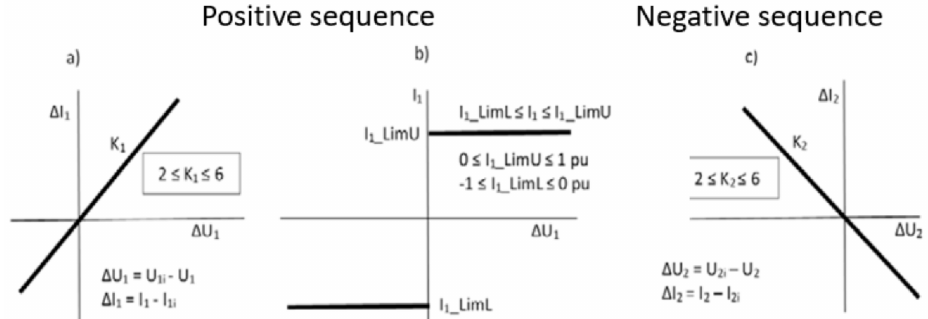
Figure 3. ( a ) Injection/consumption of additional positive reactive current ( ∆ I 1 ,r ) depending on positive voltage drop; ( b ) total reactive current Injection/Consumption limitation ( I r ); ( c ) injec- tion/consumption of additional negative reactive current ( ∆ I 2, r ) depending on negative voltage drop